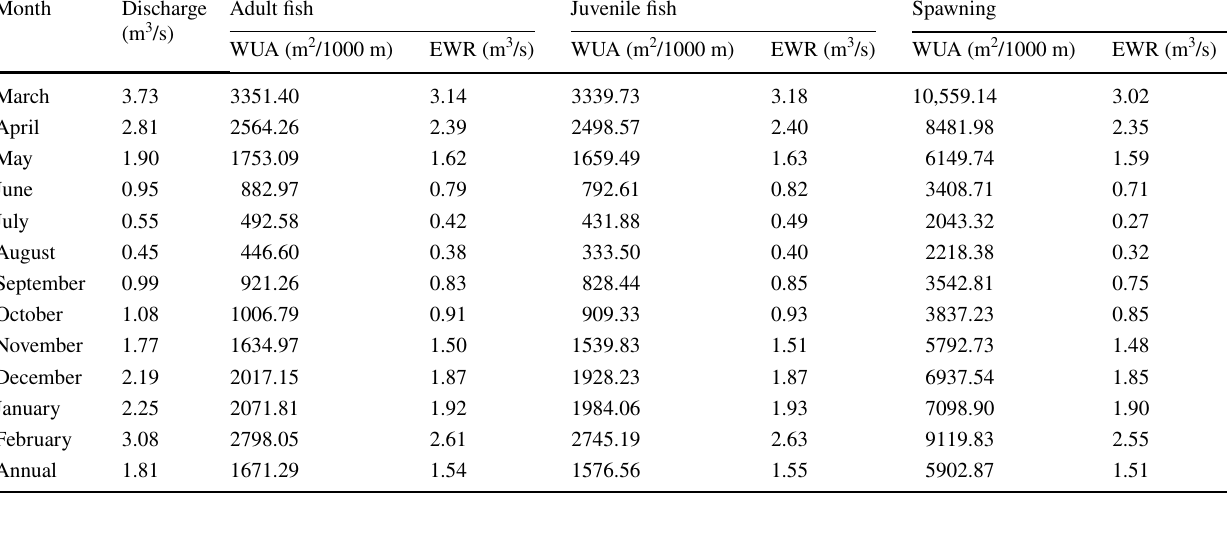
Table 2 EWR of the Qarasu river for the Rutilus rutilus caspisus in the stages of adult fish, juvenile fish, and spawning Month Discharge (m 3 /s)